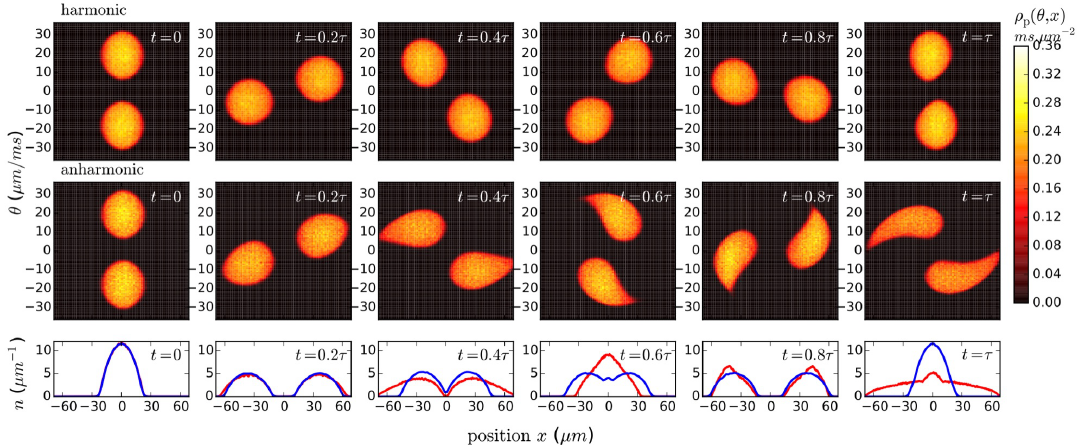
( θ , x , t ) —here plotted in the Figure 1: Evolution of the density of quasi-particles ρ p ( x , θ ) -plane— in the QNC setup, with parameters given in the text. The solution of the GHD equations are obtained from the flea gas [ 35 ] . The results are displayed for the harmonic trap (top row) and the weakly anharmonic one (middle row), on one period of the (quasi-)harmonic trap. (Bottom row) Corresponding density of particles n ( x , t ) , for the harmonic trap (blue) and the anharmonic one